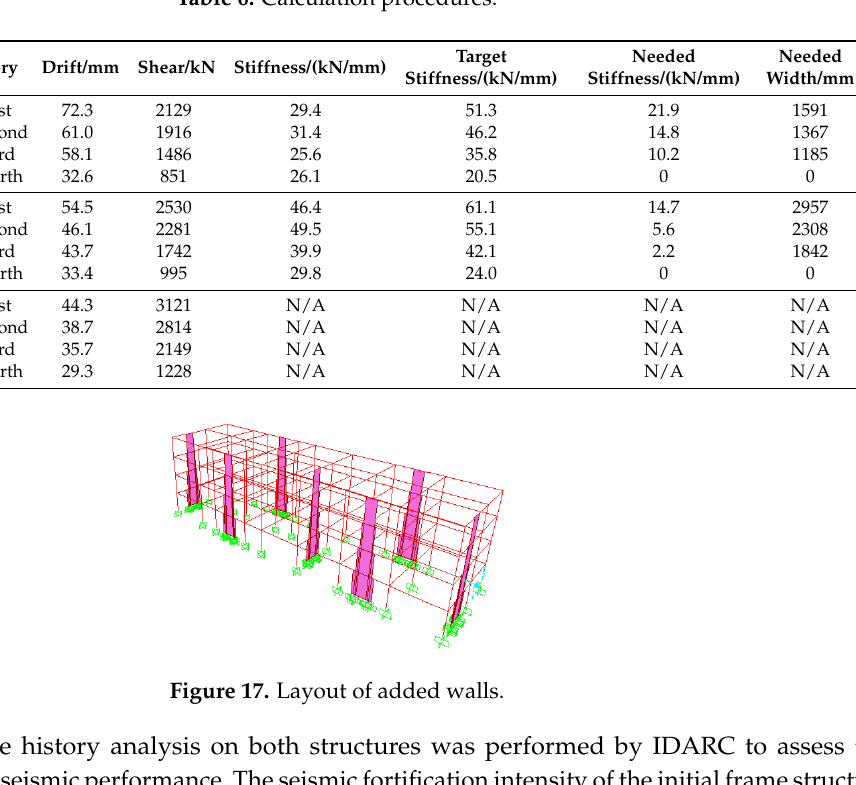
Table 6. Calculation procedures.